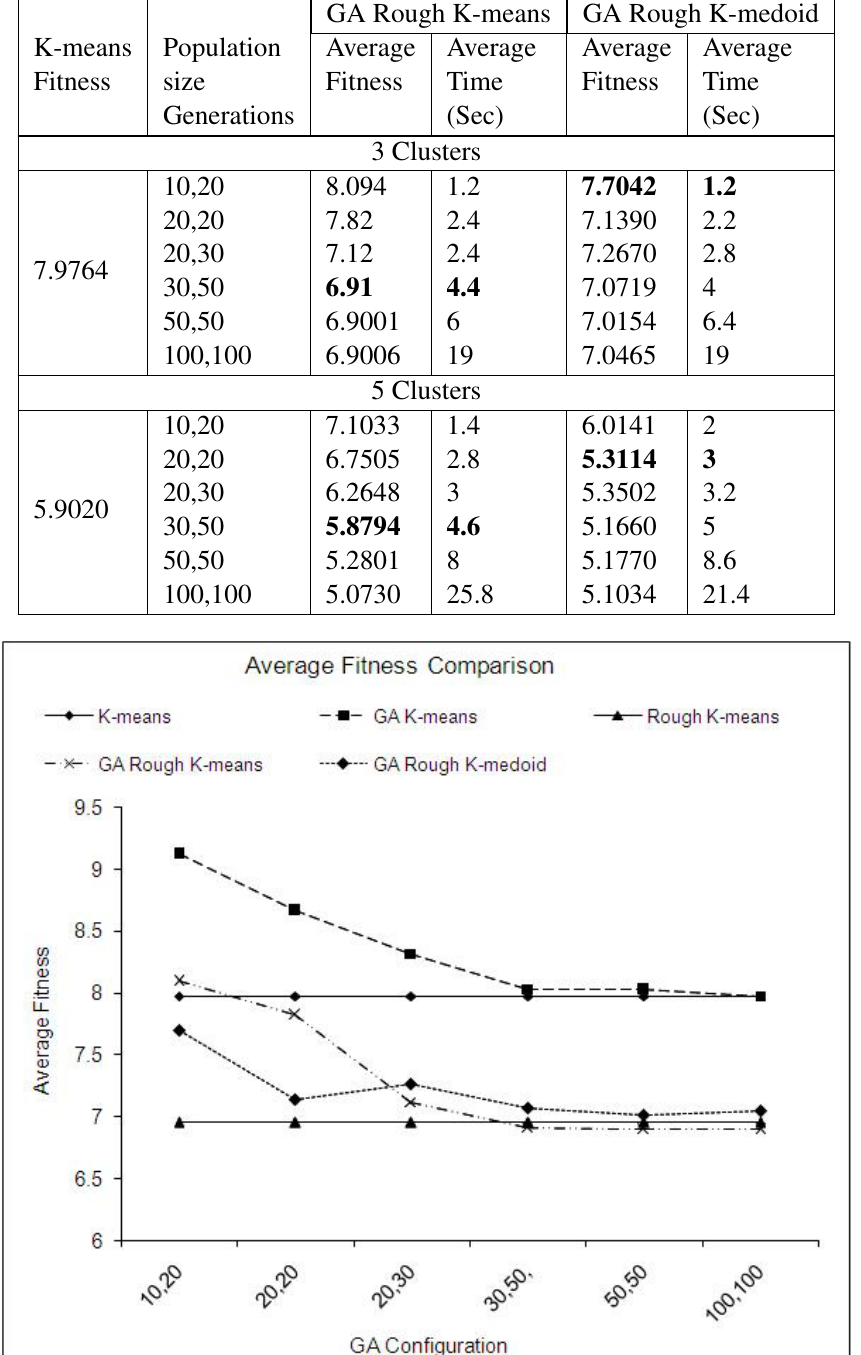
Table 4: Comparison of K-means, GA rough K-means and GA Rough K-medoid for Library Data set.